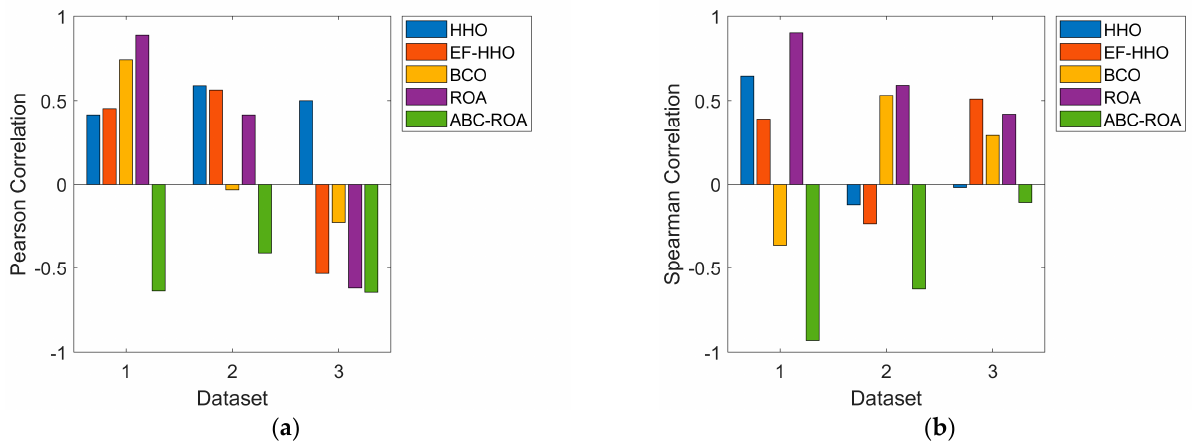
Figure 7. Effectiveness analysis of the designed blockchain-based privacy preservation model in terms of ( a ) Pearson correlation and ( b ) Spearman correlation.